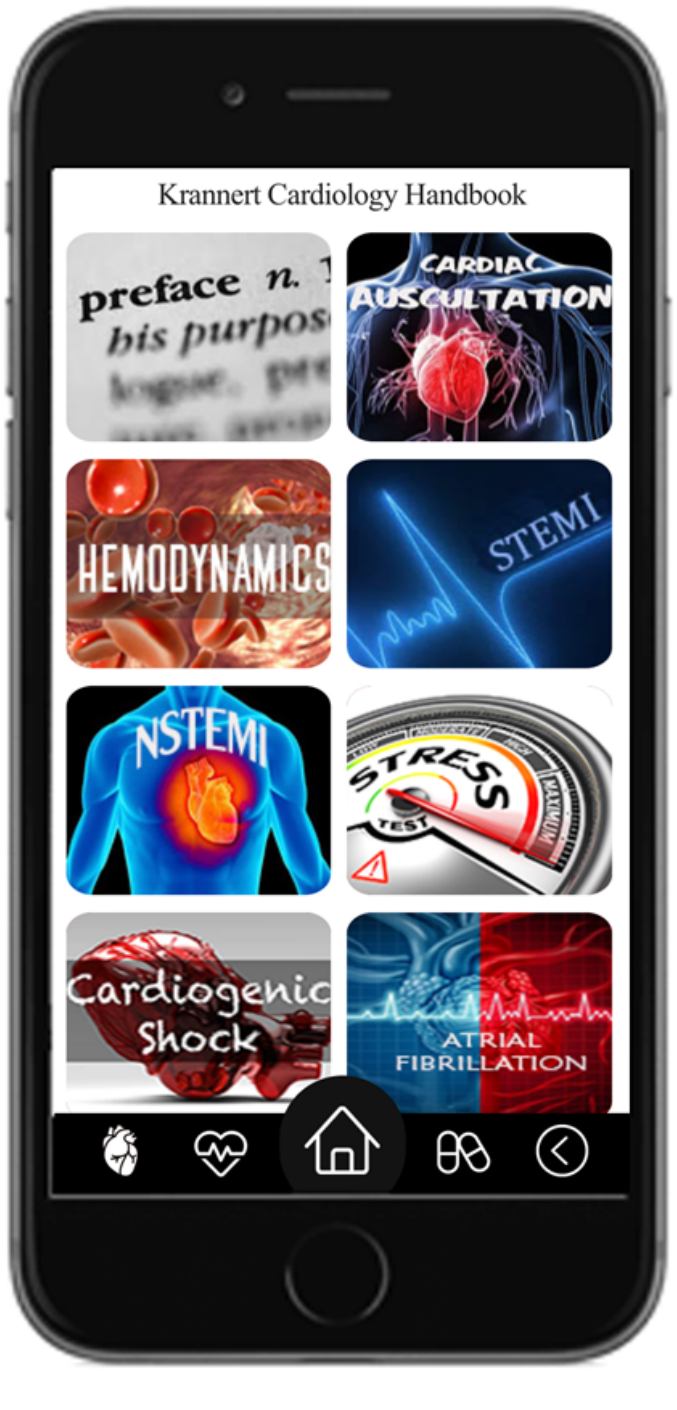
Figure 1. Table of contents of the Krannert Cardiology Handbook app. Chapters not visualized in the figure are tachyarrhythmia, bradyarrhythmia, syncope, pulmonary hypertension, cardiogenic pharmacology, and introduction to